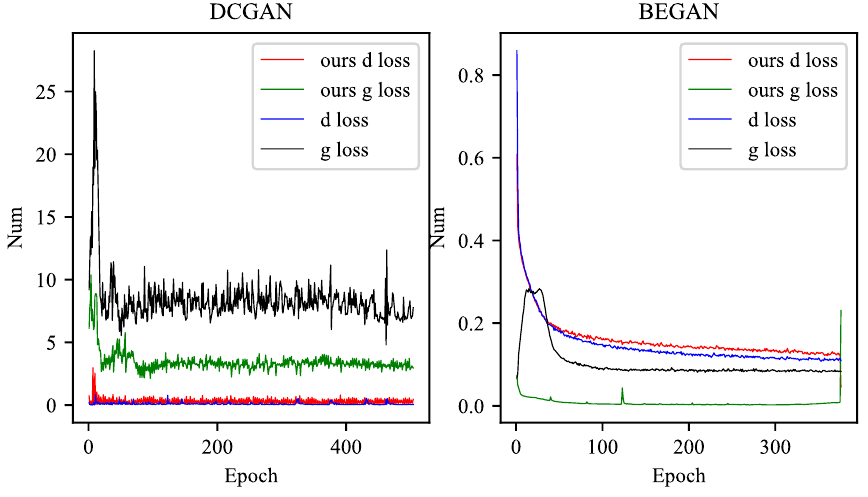
Figure A1. The results of the DCGAN [33] and BEGAN [28]